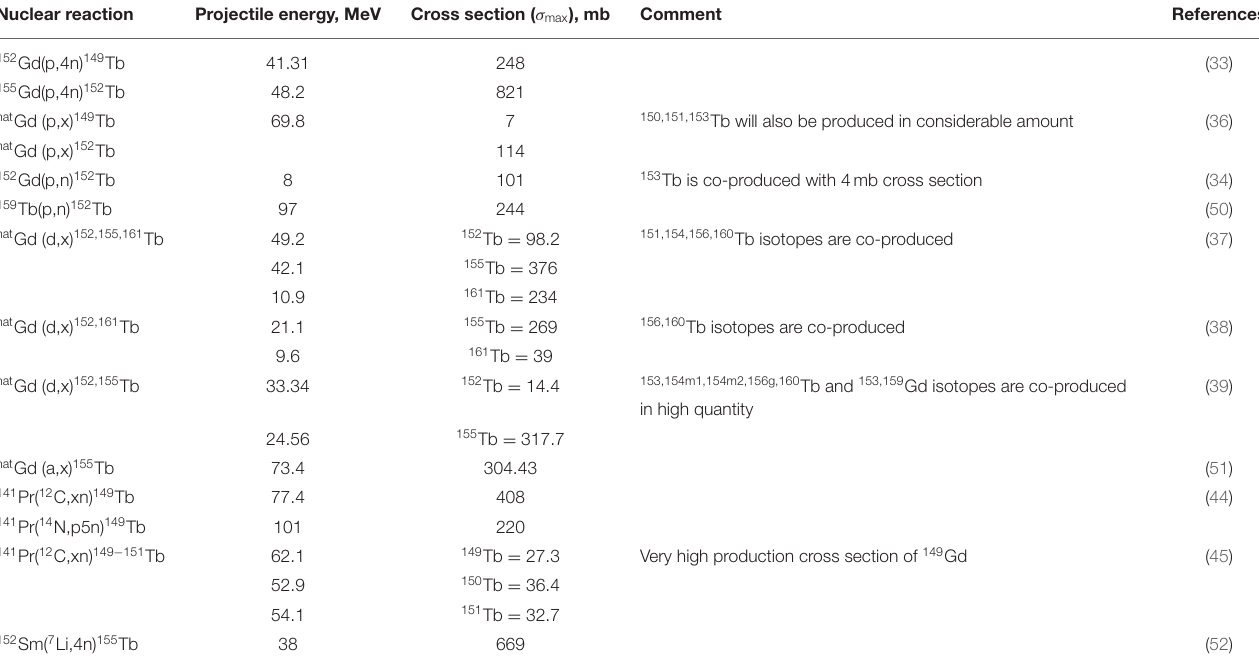
TABLE 3 | Available production cross section data of terbium radionuclides. Nuclear